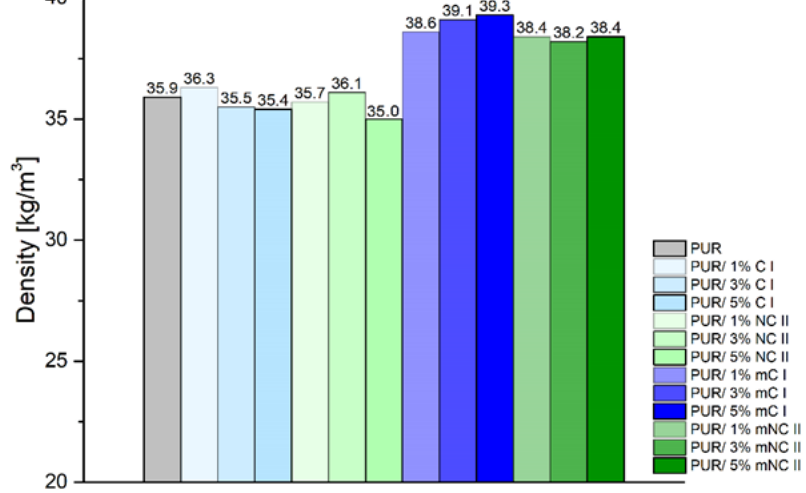
Figure 6. Density of composites.